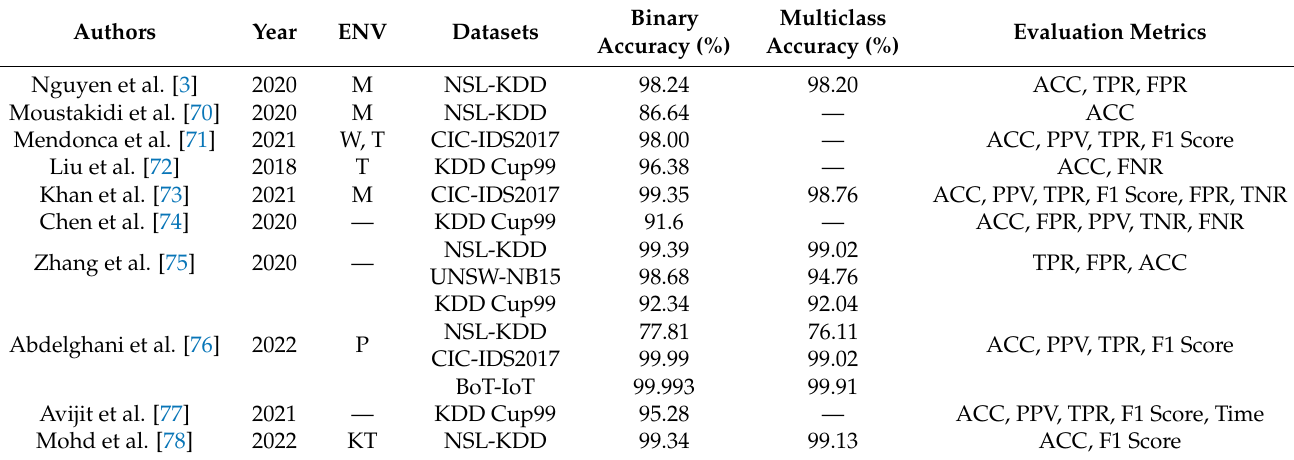
Table 11. Properties of group 4 (Hybrid CNN and Machine Learning) IDS